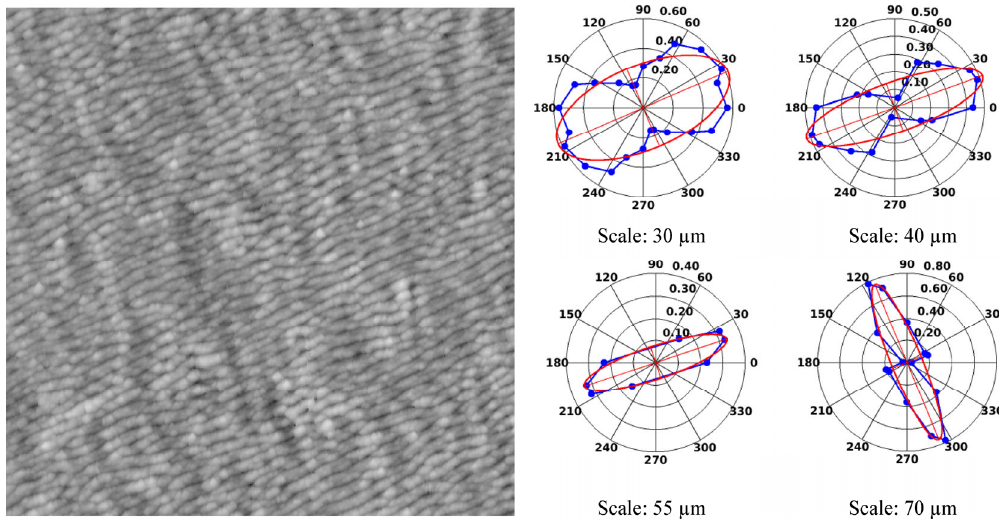
Fig. 4 Image of the textured surface together with the DFS analysis results presented as Rose plots at four scales.